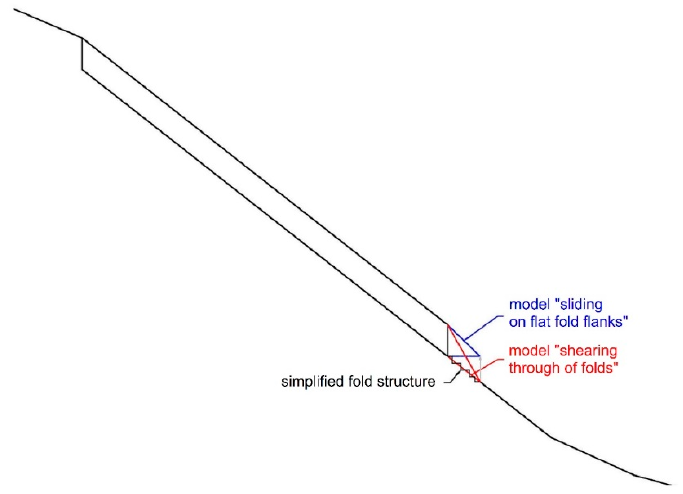
Figure 5. Simplified fold structure and deduced calculation models.